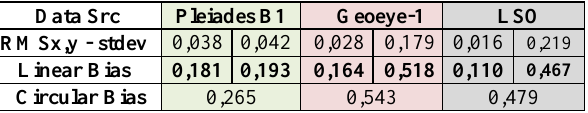
Table 3. Bias calculations